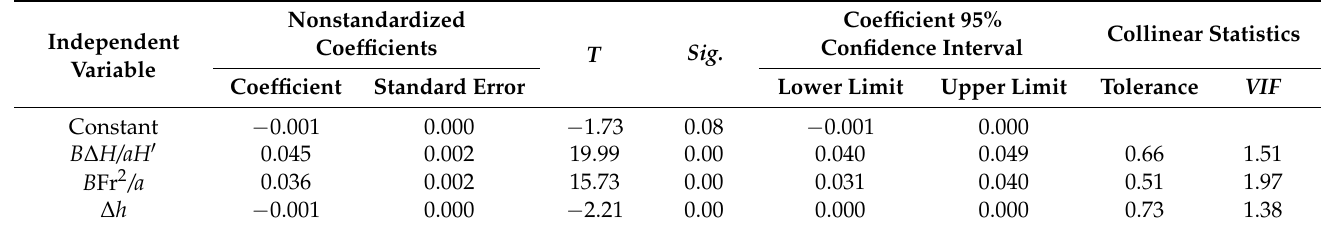
Table 2. Significance analysis of the